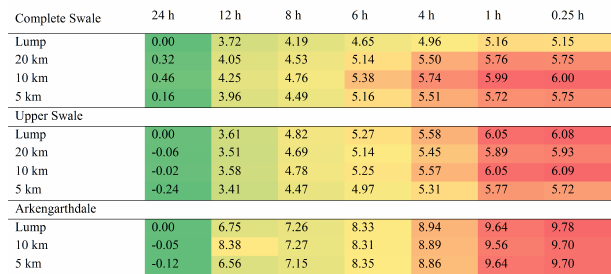
Table 6. The percentage deviations for each catchment of the vol- ume of hydrological outputs above the 95th percentile using differ- ent spatio-temporal resolutions.